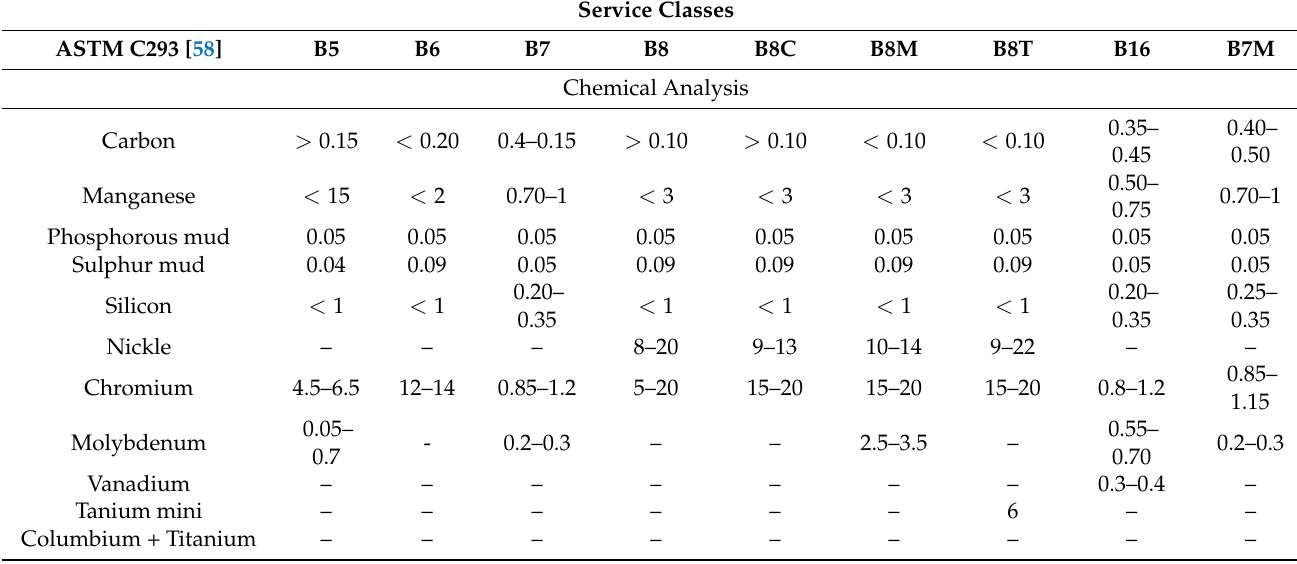
Table 2. Mechanical characteristics of the